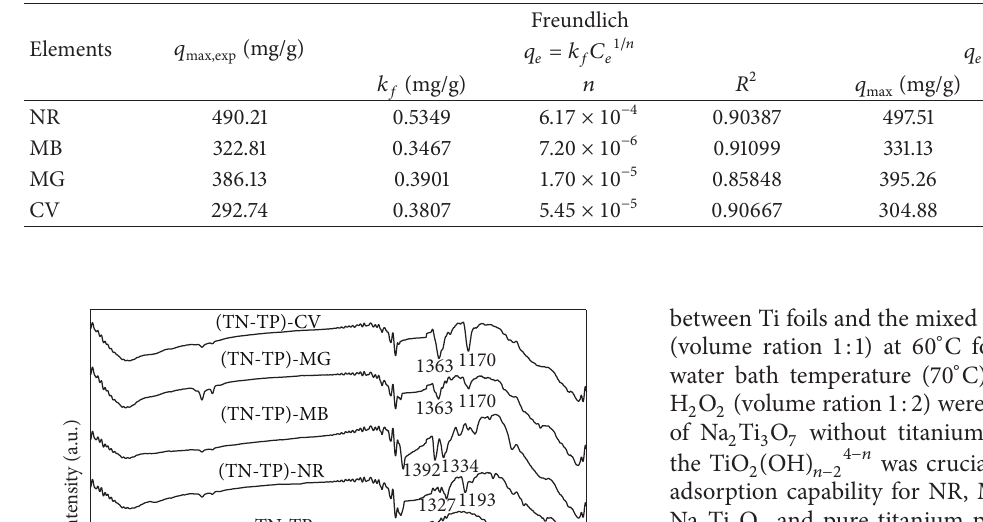
Table 3: Isotherm coefficients according to Freundlich and Langmuir.